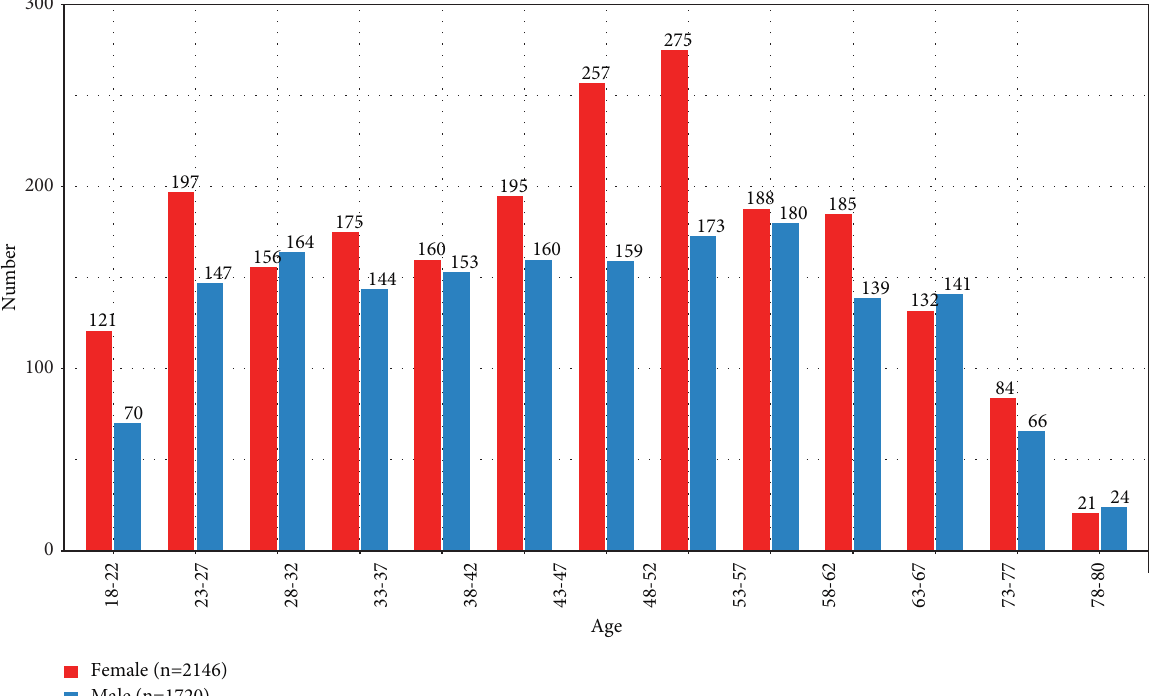
Figure 2: The age distribution of the